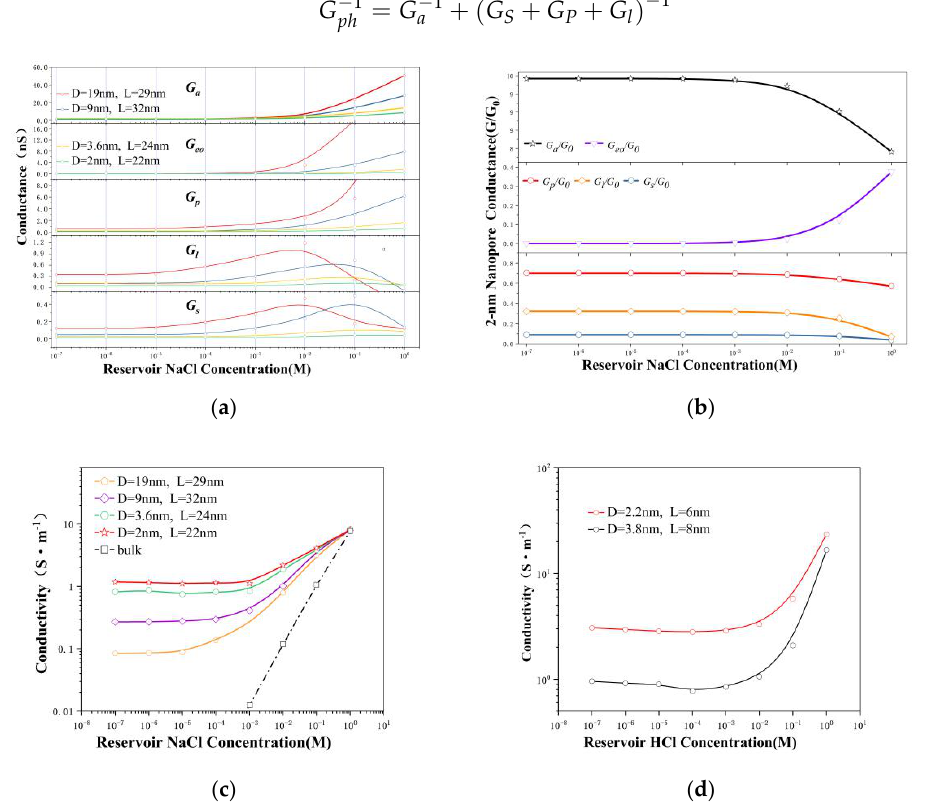
Figure 3. Ionic conductance and conductivity. ( a ) Access conductance ( Ga ), nanopore conductance ( Gp ), surface conductance ( Gs ), electric potential leakage conductance ( G l ), and electroosmotic con- ductance ( Geo ) of NaCl solution. ( b ) In 2 nm nanopore, ratio of 𝐺 𝑎 ,𝐺 𝑝 ,𝐺 𝑙 ,𝐺 𝑠 ,𝐺 𝑒𝑜 to the total ionic conductivity ( 𝐺 0 ) as a function of reservoir concentration. ( c ) Ionic conductivity of Nacl solution. ( d ) Ionic conductivity of Nacl solution.